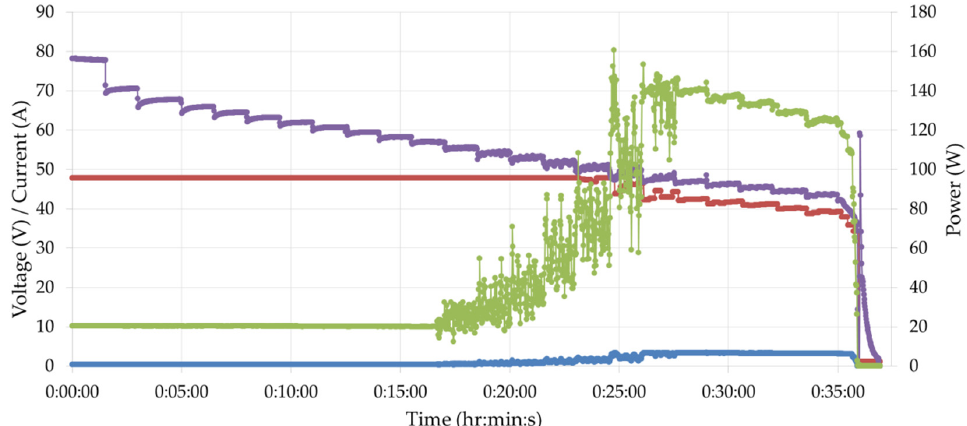
Figure 13. Characteristics of air supply fans: current (blue line), voltage (red) and power (green) of fans and voltage at the PEMFC output (purple line) during tests.